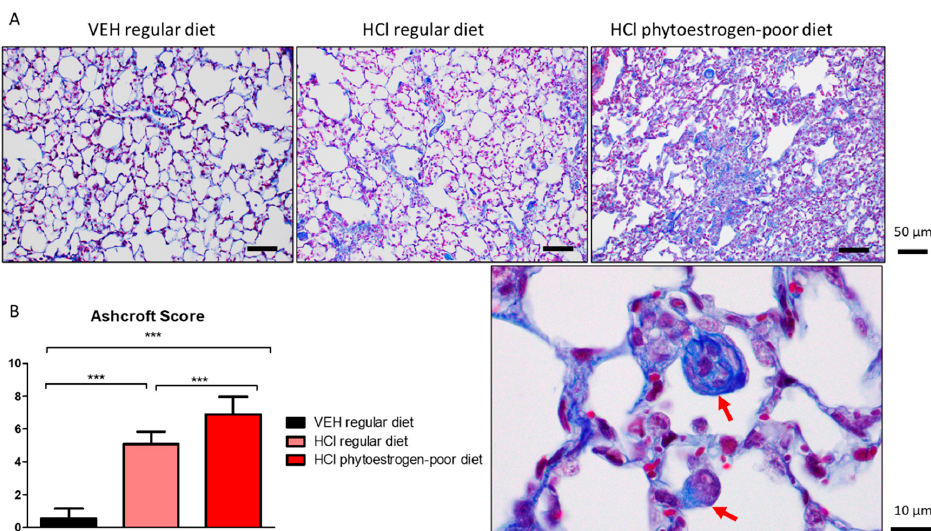
Figure 4. HCl induces pulmonary fibrosis. ( A ) Masson’s Trichrome staining of lung sections demonstrates moderate collagen deposition in regular diet-fed HCl-instilled mice and total fibrous obliteration, and loss of parenchymal architecture in isoflavones-poor diet-fed mice. ( B ) The Ashcroft score depicts severe fibrosis in HCl-instilled mice on phytoestrogen-free diet, a milder pathology in HCl-instilled mice on regular diet and no significant changes in saline-instilled mice. (Means ± SEM; n = 3; ***: p < 0.001; with one-way ANOVA and Tukey’s); VEH: Vehicle.